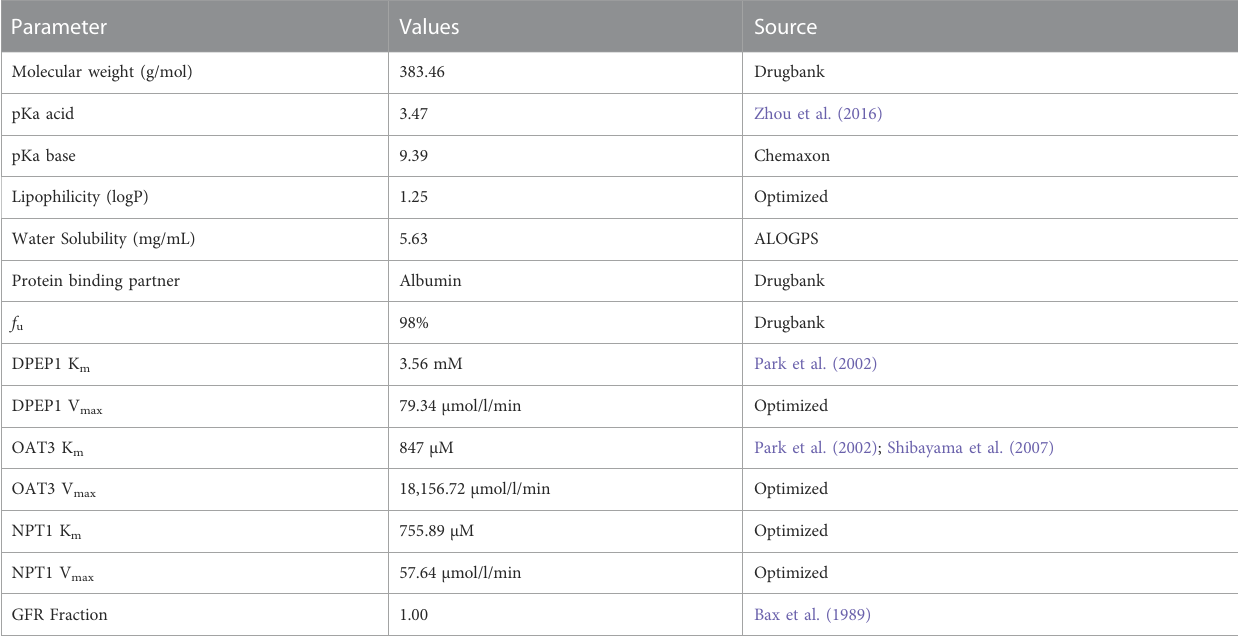
TABLE 2 Physiologically-based pharmacokinetic input parameters of meropenem.